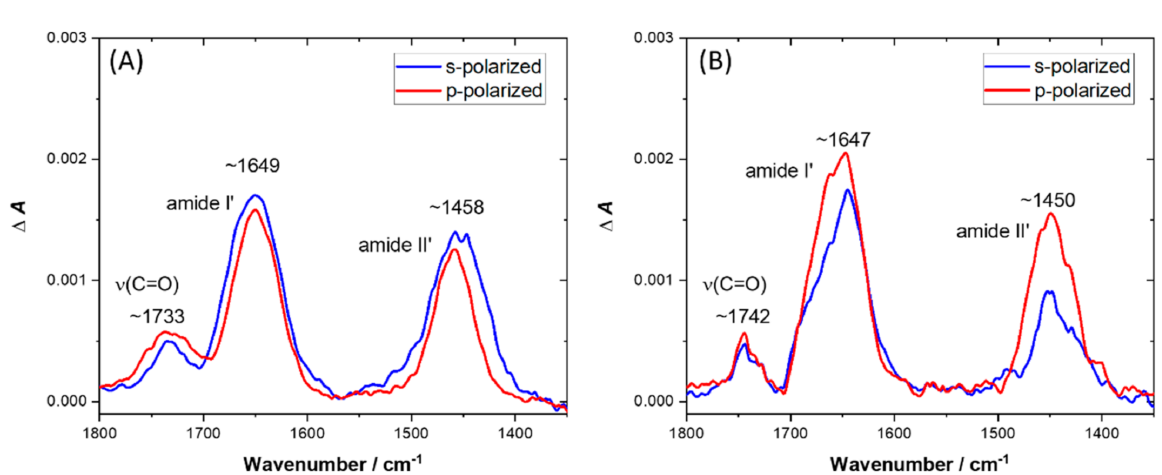
Figure 6. ATR-FTIR spectra in amide region recorded for DPPG/POPG/CL bilayer deposited onto the Si prisms after ~60 min of exposure to LC10-OP ( A ) and BC10-OP ( B ). The spectra were recorded in 0.01 M PBS dissolved in D 2 O. The red line corresponds to the spectrum recorded with p-polarized light, while the blue line corresponds to the spectrum recorded with s-polarized